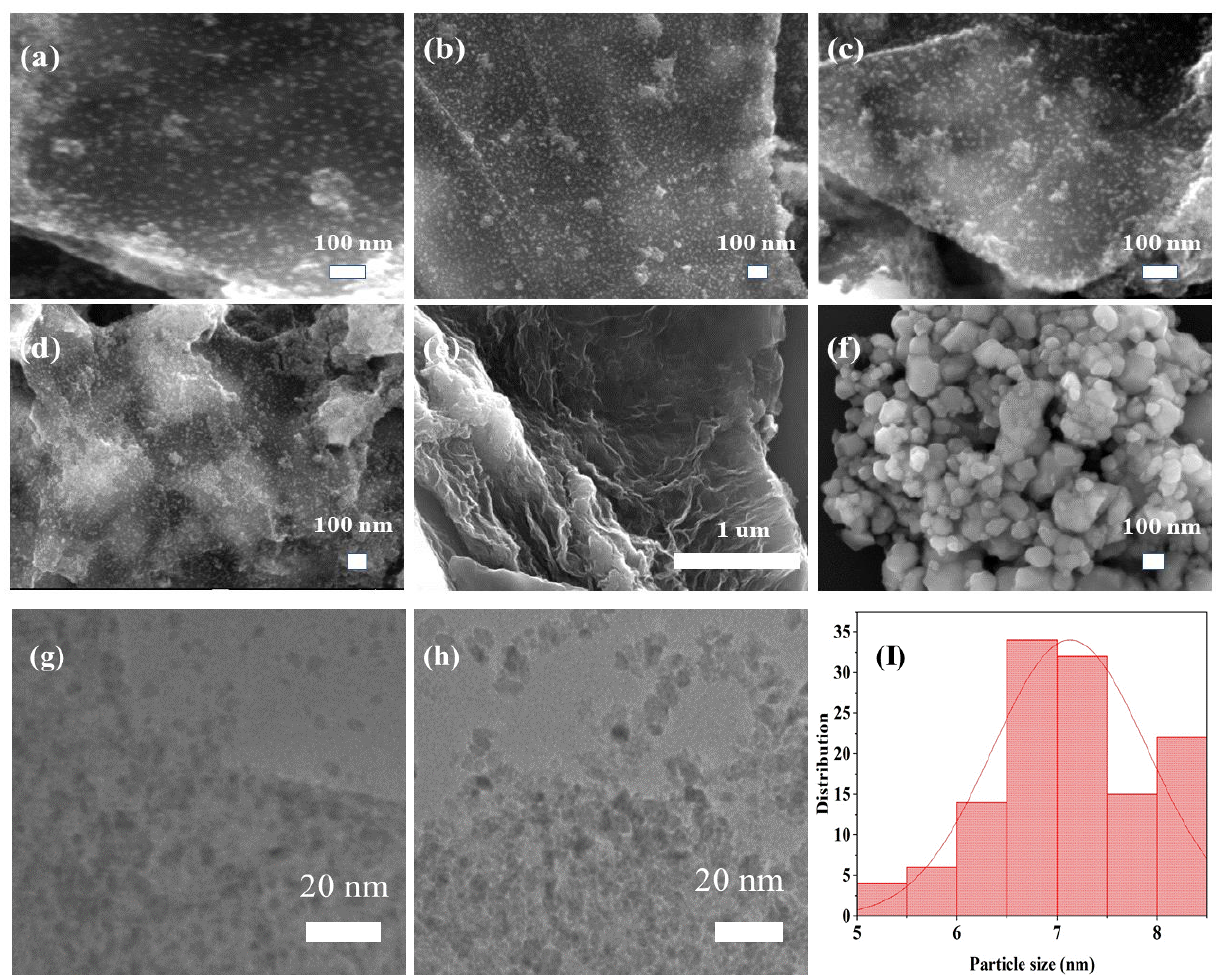
Figure 2. ( a – f ) SEM images of ZrO 2 /RGO composite T1–T4, RGO, ZrO 2 . ( g , h ) TEM images of composite T2 and T4. ( I ) the size distribution of ZrO 2 .